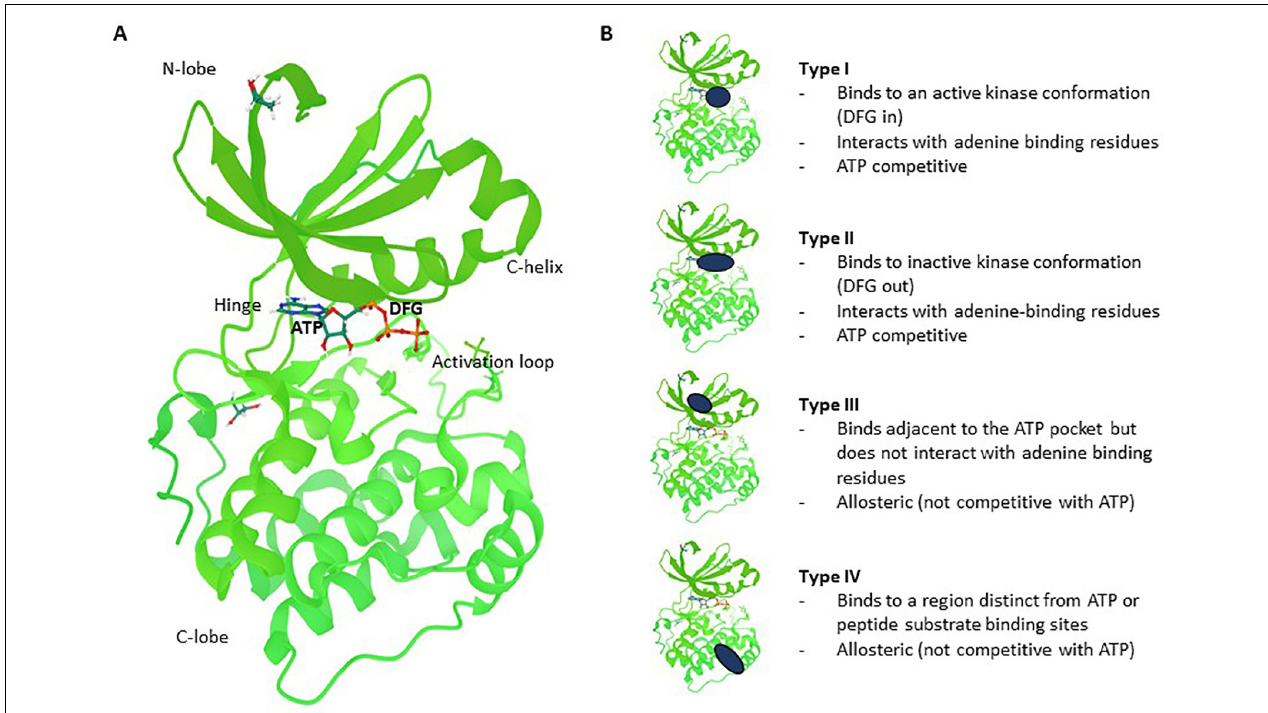
FIGURE 1 | Kinase structure and different types of reversible small molecule kinase inhibitors. (A) Co-crystal structure of PDK1 (green) with ATP (shown in ball and sticks). Regions indicated are the N-lobe (N-terminal domain), C-lobe (C-terminal domain), C-helix, Hinge, Activation loop and the DFG regulatory motif which sits just behind part of the ATP molecule colored in orange (4RRV, PDB). (B) Type I inhibitors bind to the active conformation of the kinase, interact with the hinge motif and are ATP competitive. Type II binders are also ATP competitive but occupy a “back pocket” which exists in a subset of protein kinases. Type III ligands bind in a distinct hydrophobic pocket near the ATP binding site and are uncompetitive with ATP. Type IV inhibitors bind to distinct surface pockets away from the ATP binding site and are also uncompetitive with ATP. The PKD1 structure is used here to illustrate the different types of